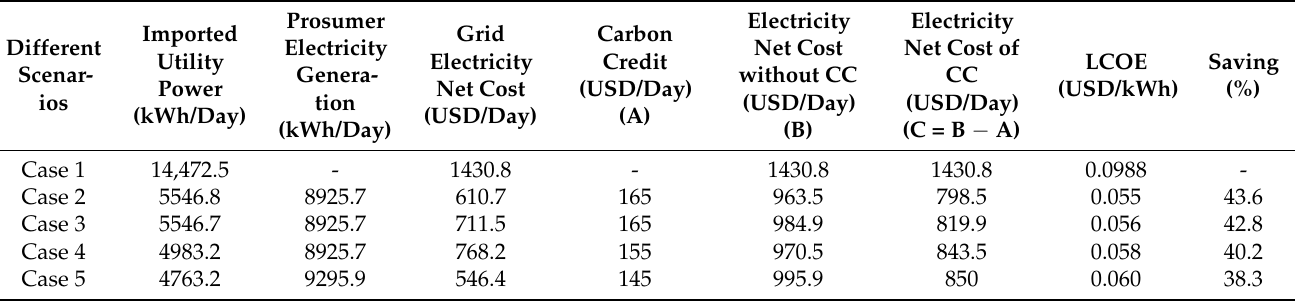
Table 5. Proposed system calculation using LCOE.